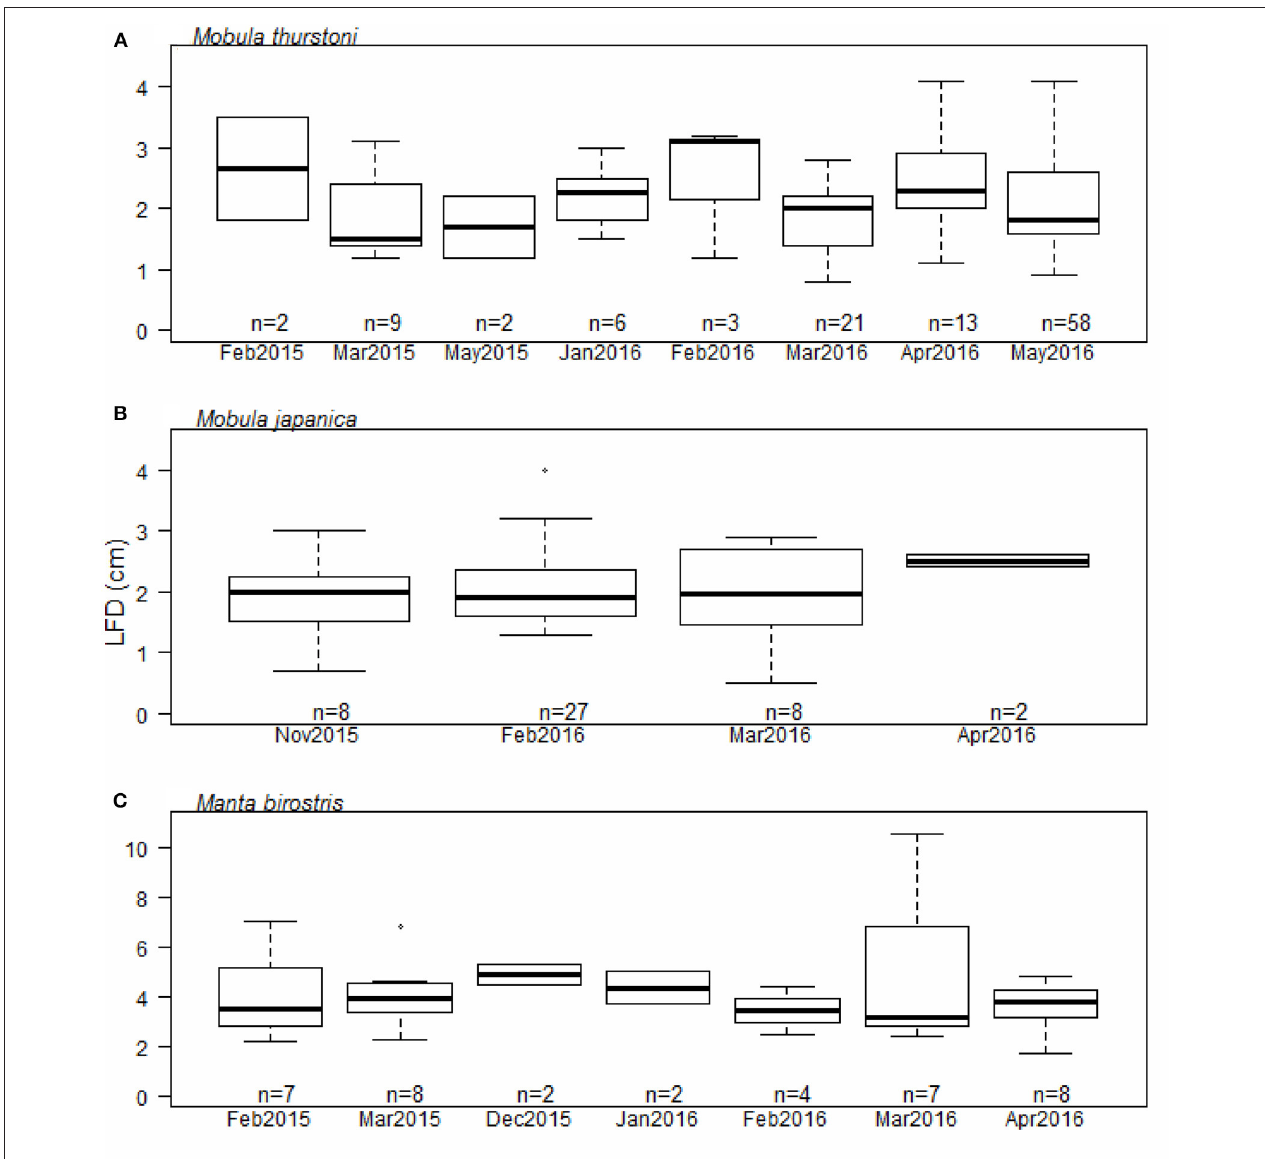
FIGURE 4 | Largest follicle diameter distribution per month for (A) M. thurstoni, (B) M. japanica , and (C) M. birostris . For each distribution, horizontal lines from bottom to top: lower value, first quartile, median, third quartile, and upper value. Dots in (B,C) represent suspected